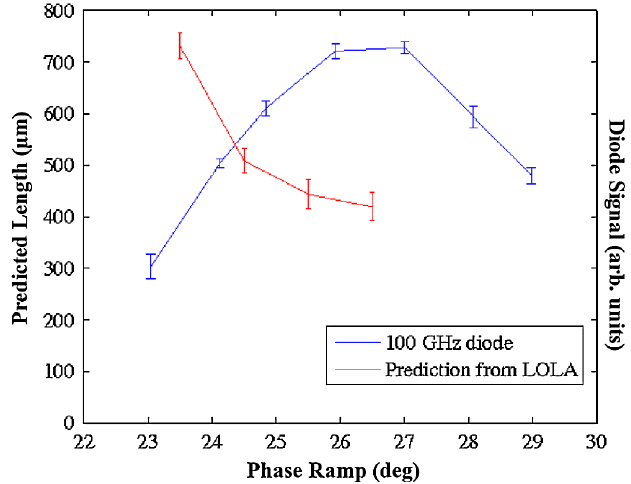
FIG. 9. (Color) Output of the 100 GHz diode during a phase ramp scan, plotted alongside the predicted bunch length from the transverse cavity measurements (‘‘LOLA’’ refers to the name given to the transverse deflecting cavity technique in the original paper [3].